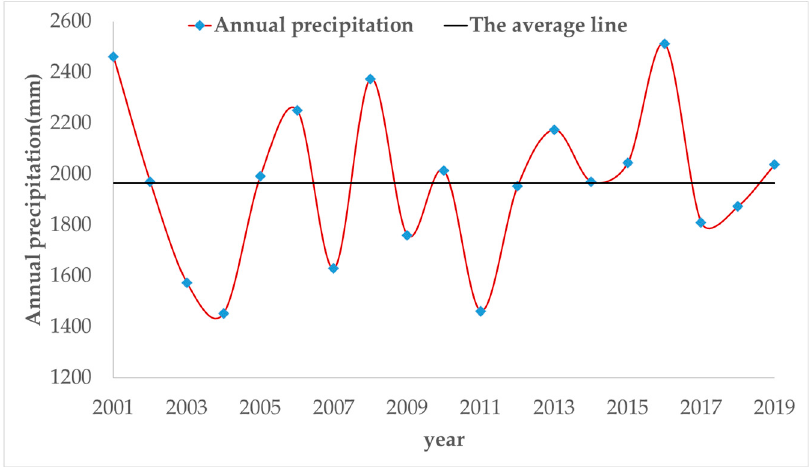
Figure 7. Total annual precipitation from 2001 to 2019.